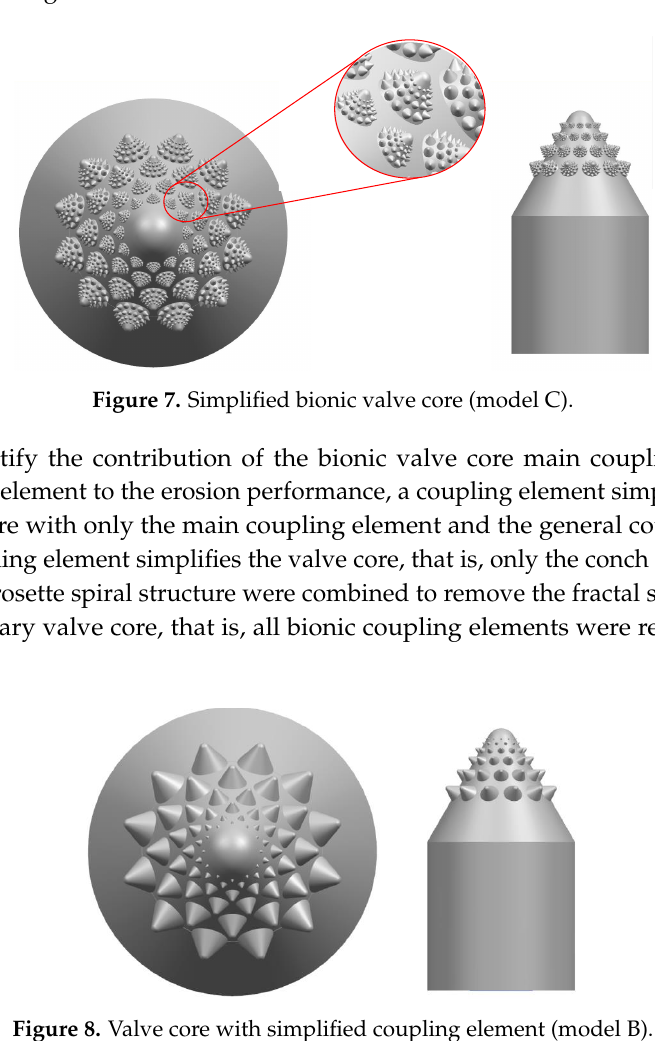
Figure 8. Valve core with simplified coupling element (model B).